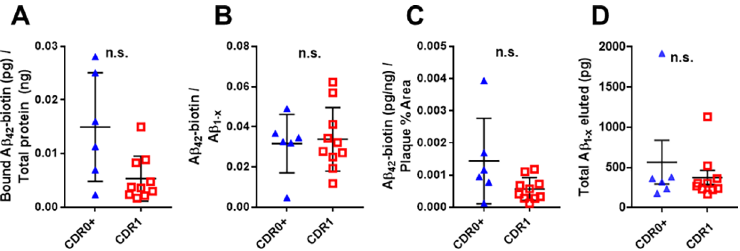
Fig 4. Assessments based on enzyme-linked immunosorbent assay of bound A β 1-42 -biotin does not distinguish between elderly high-pathology controls and elderly subjects with mild ADD. ( A ) There was no difference between groups in the levels of overall A β 1-42 -biotin recovered from dissociated tissue, as measured using an indirect ELISA which only detects biotinylated A β (not significant [n.s.] by Mann–Whitney U test). Data expressed as picograms A β per nanogram of total measurable protein. ( B ) The ratio of the amount of A β 1-42 -biotin to the amount of A β 1-x as measured by sandwich ELISA was not different between groups (not significant [n.s.] by Mann–Whitney U test). ( C ) The ratio of A β A β 1-42 -biotin as measured by sandwich ELISA to the percent gray matter plaque coverage did not differ between groups (not significant [n.s.] by Mann–Whitney U test). (D) There was no difference between groups in the levels of overall A β 1-x recovered from dissociated tissue, as measured using an sandwich ELISA (not significant [n. s.] by Mann–Whitney U